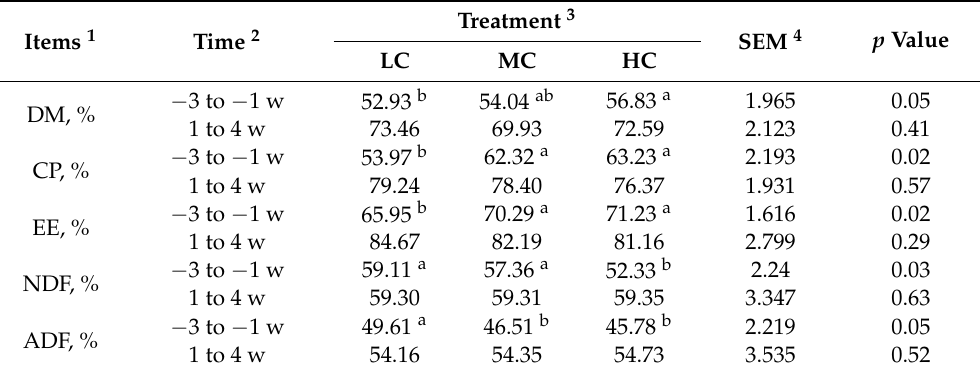
Table 8. Effects of different prenatal concentrate levels on the apparent nutrient digestibility of prepartum and postpartum dairy